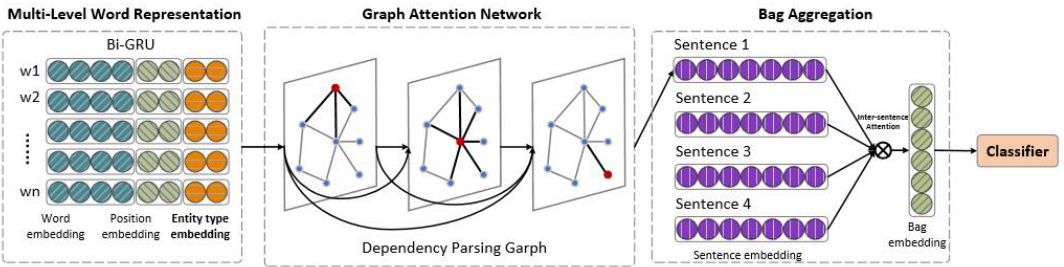
Figure 2. The framework of the proposed Semantic Enhanced Graph attention networks Relation Extraction (SEGRE). SEGRE first encodes each word in the sentence by concatenating word, position, and entity type information. Then the sentence representation is achieved by constructing a graph attention network using a syntactic dependency tree. Next, the bag representation is calculated by weighting sentence embeddings using intra-bag attention. Finally, the bag representation is fed to a softmax classifier to get the relation of the entity